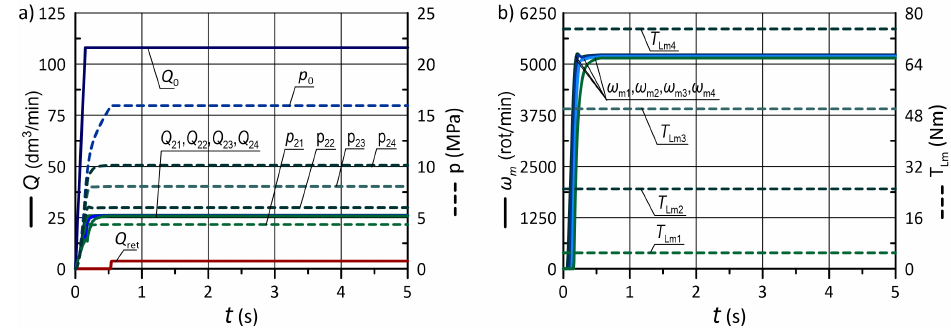
Figure 13. Results with various loads of individual motors from the range of 5 − 75 N m: ( a ) flow rates and pressures; ( b ) rotational speed of hydraulic motors and load